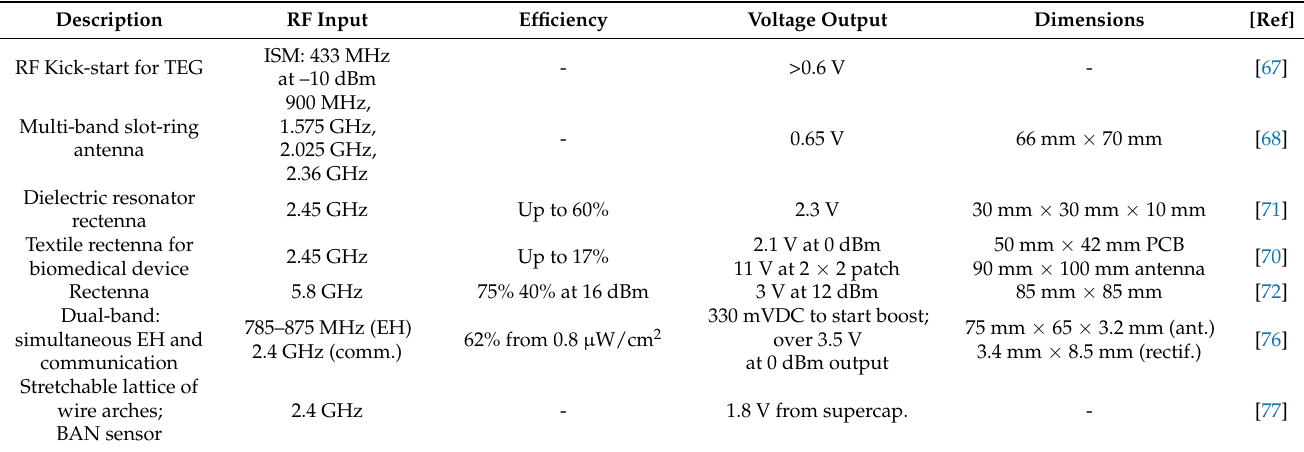
Table 8. Comparison of RF energy harvesters.